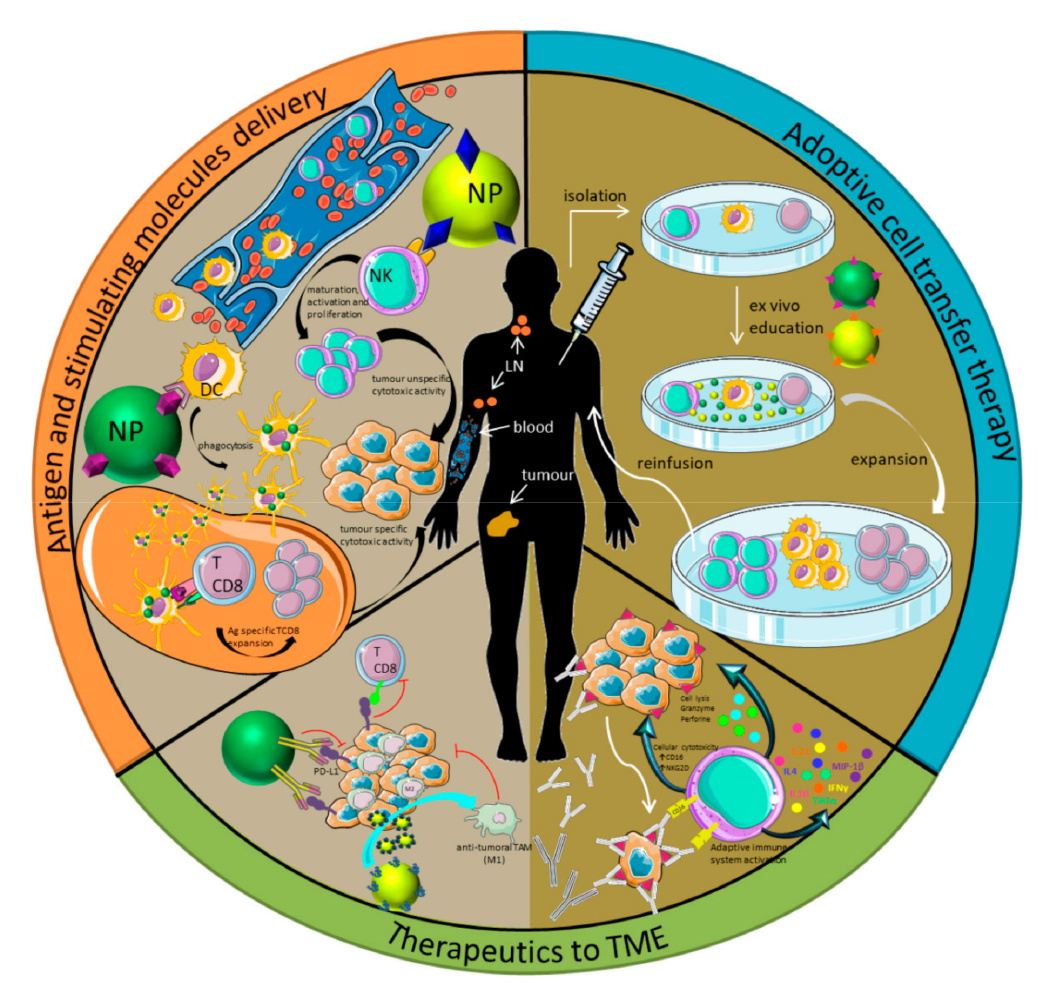
Figure 1. Classification of immunotherapy strategies. Active (pale brown on the left) vs. passive immunotherapy (dark brown on the right). The three main immunotherapy strategies used in cancer treatment are shown in the figure separately: (1) Antigen and stimulating molecule delivery (orange); (2) Adoptive transfer therapy (blue); and (3) Therapeutics to the tumor microenvironment (TME) (green). Figure adapted from [20,27]. NP: nanoparticle; NK: natural killer; DC: dendritic